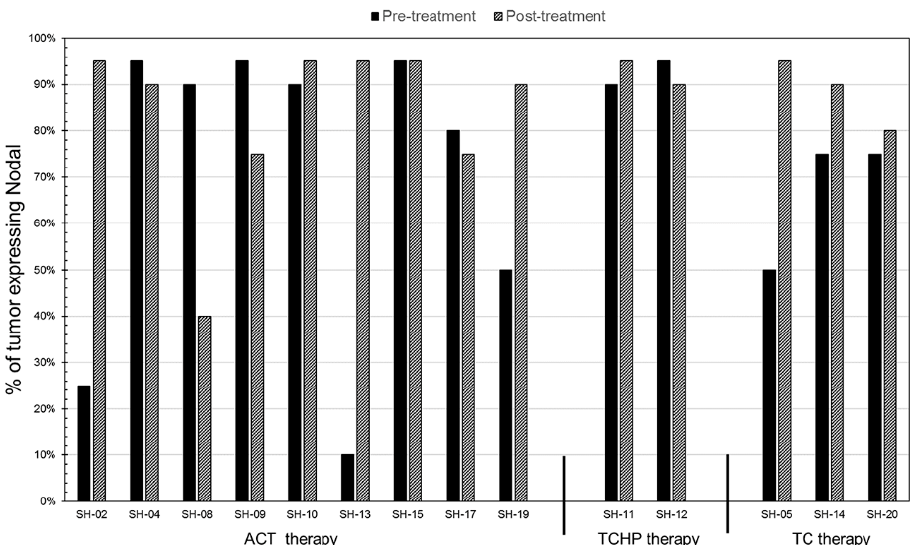
Figure 1. Clinically derived tissue sections from breast cancer patients, both pre ‐ and post ‐ treatment with current standard ‐ of ‐ care therapy (ACT, TCHP, and TC), were examined for the presence of Nodal protein by immunohistochemistry. The results are presented as a graph representing the percent of the tumor(s) that expresses Nodal categorized by the therapeutic treatment. Percent of tumor expressing Nodal is relative to Nodal measured in the entire tumor where 100% represents every tumor cell expressing Nodal.